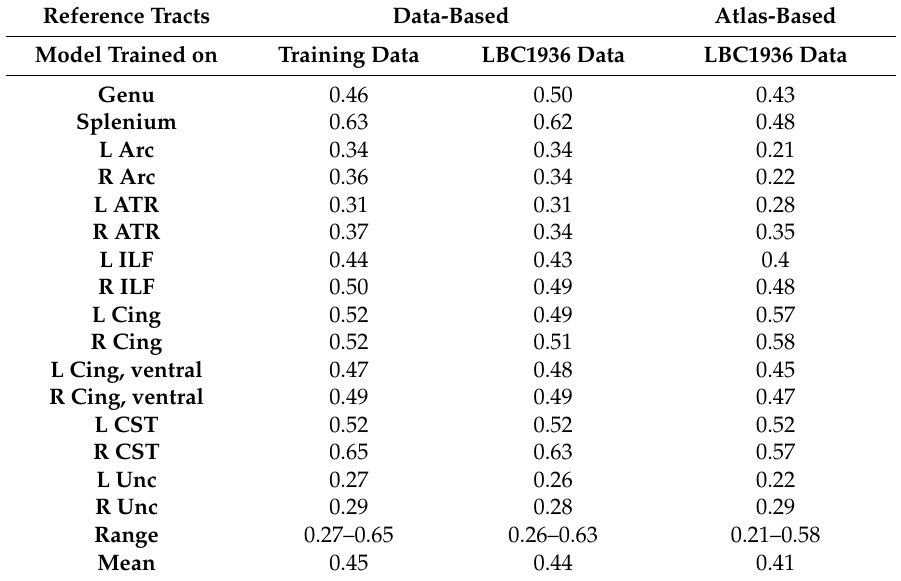
Table 3. Dice overlaps between segmented tracts and white matter atlas.